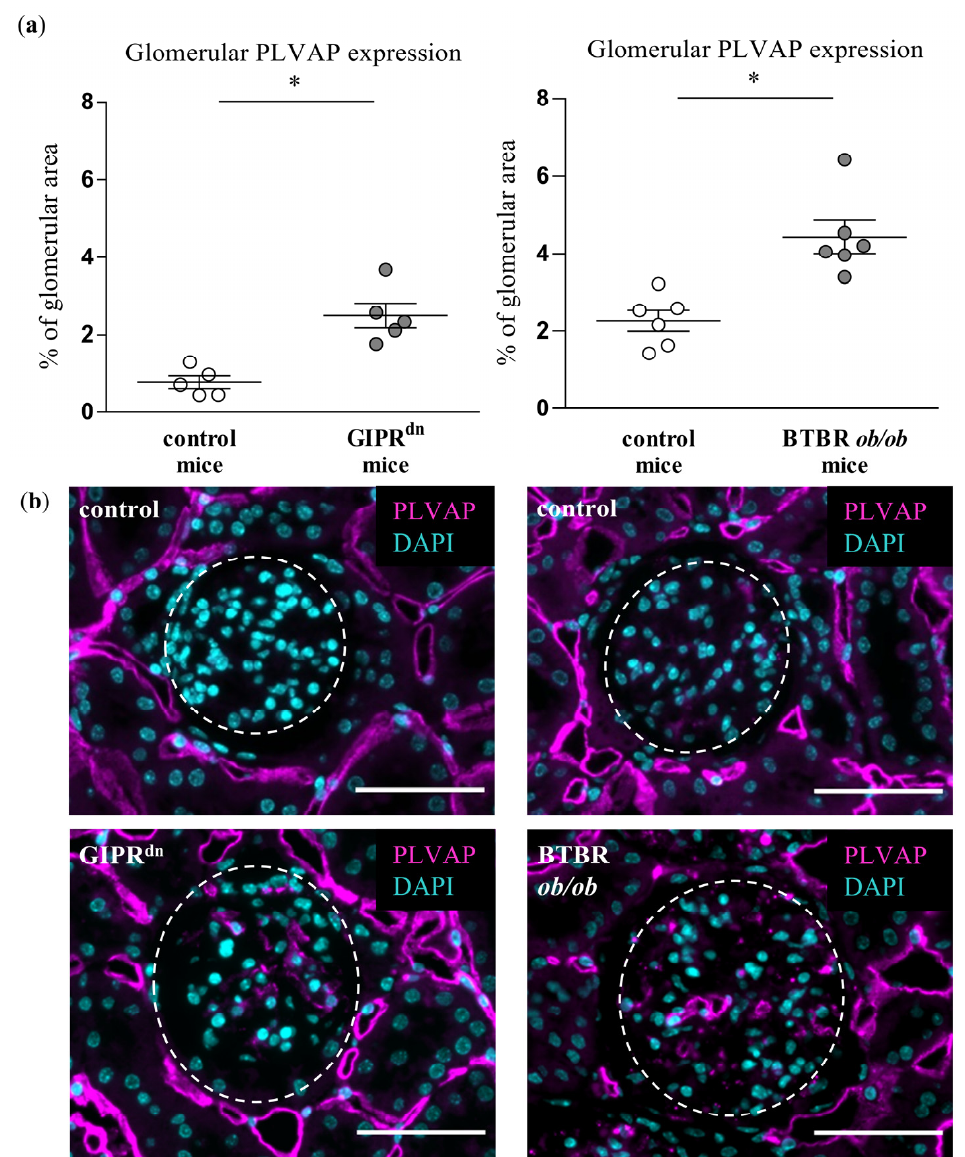
Figure 1. Analysis of plasmalemma vesicle-associated protein (PLVAP) in diabetic kidney disease models. ( a ) Automatic histological evaluation of PLVAP-positive area in glomeruli of GIPR dn mice ( left , diabetes mellitus type 1 model) and BTBR ob/ob mice ( right , diabetes mellitus type 2 model) compared to their corresponding healthy control mice. Scatter dot plot with means and SEM, * p < 0.05, n = 5–6. ( b ) Representative images of histological kidney sections stained for PLVAP (magenta) and the nuclear marker 4 ′ ,6-diamidino-2-phenylindole (DAPI, cyan). The dashed line borders the glomeruli. Scale bar: 50 µm.